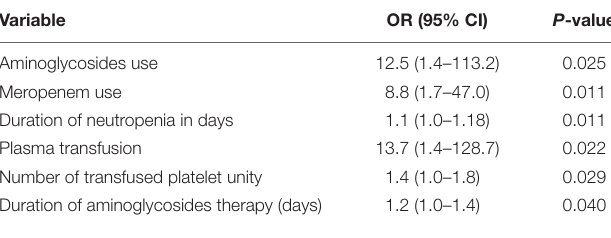
TABLE 2 | Conditioned univariate logistic regression analysis for Saprochaete -positive blood cultures risk factors. Variable P